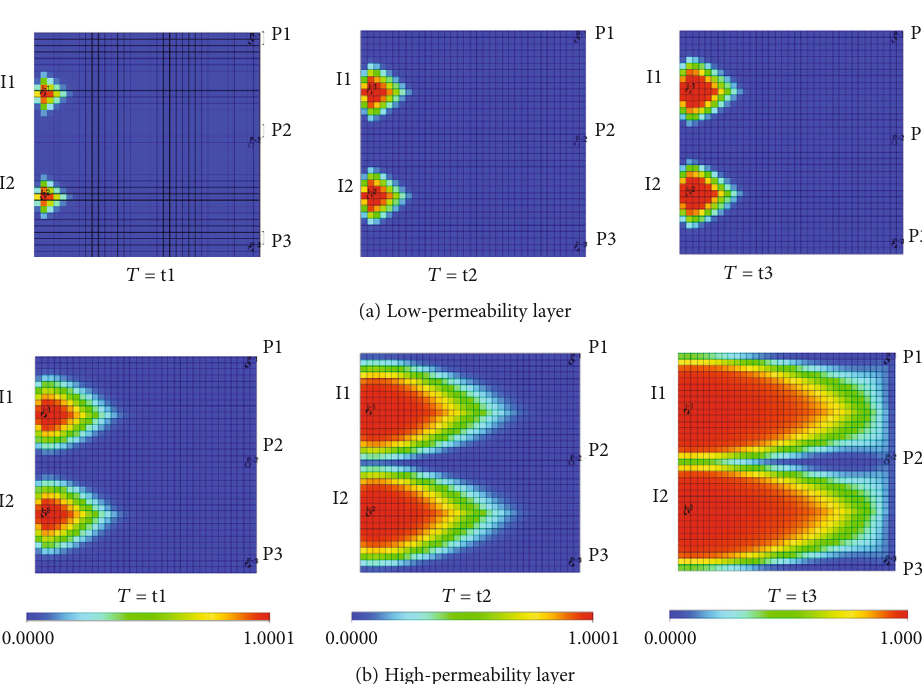
Figure 4: Distribution of injected fl uid at di ff erent time in pure water fl